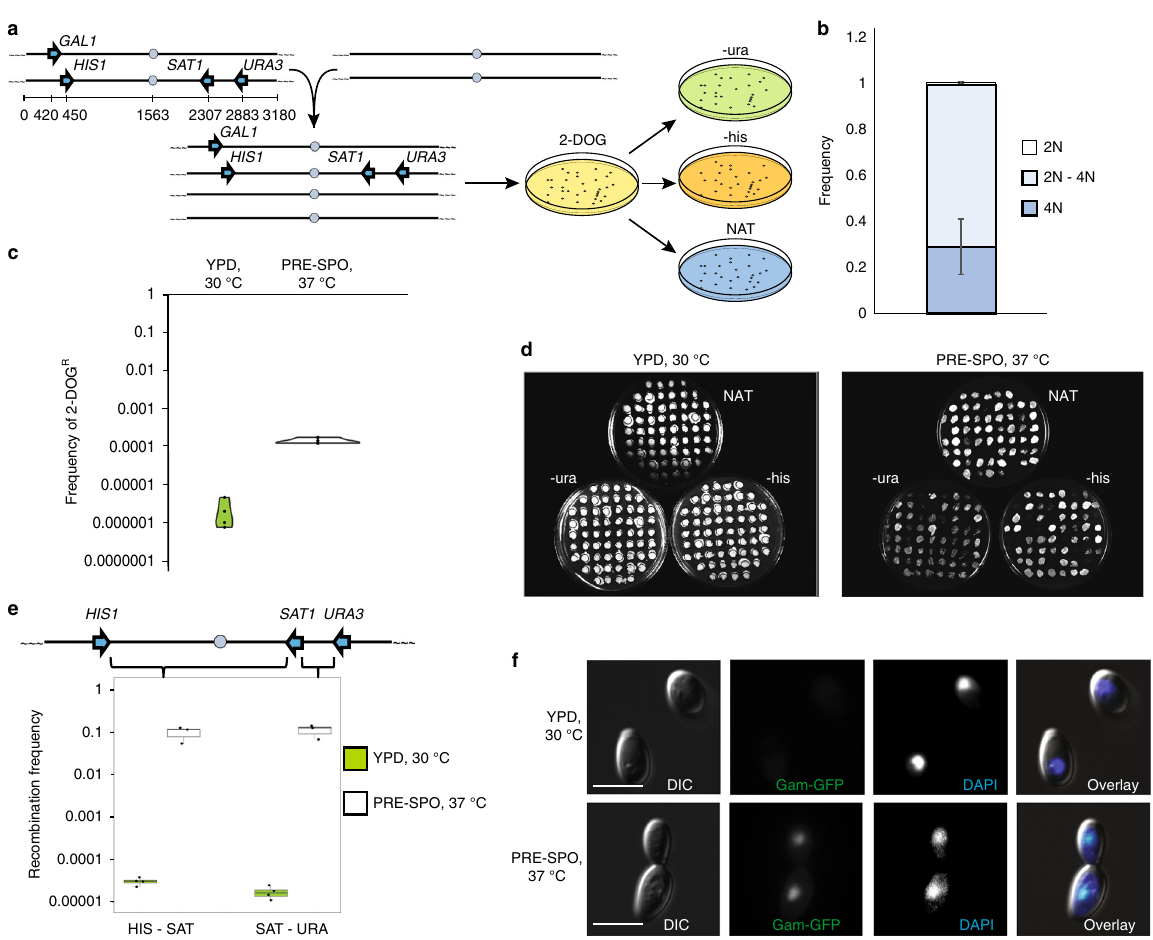
Fig. 1 High rates of inter-homolog recombination during concerted chromosome loss (CCL). a Schematic showing the construction and screening of a genetically marked tetraploid strain for monitoring chromosome loss and recombination. b Frequency of different ploidy states in 2-DOG R ( gal1 − ) progeny derived from tetraploid cells by CCL. Error bars signify standard deviation. n = 3 biologically independent experiments. c Frequency of 2-DOG R colonies following growth of the genetically marked tetraploid strain on solid agar under standard conditions (green; YPD, 30 °C) or under conditions that promote CCL (white; PRE-SPO medium, 37 °C) for 7 days. n = 4 biologically independent experiments. d Example images of selection plates indicating growth of progeny on selective media for different markers. e Recombination frequencies in HIS1-SAT1 and SAT1-URA3 intervals following growth on standard medium (green) or CCL-inducing medium (white) for 7 days. SAT1 encodes resistance to nourseothricin (NAT R ). Boxplots are presented as the 75th to 25th percentile with the thick line denoting the median. Whiskers indicate the largest and smallest values within 1.5 × of the interquartile range. f C. albicans tetraploid cells expressing the Gam-GFP construct following 24 h growth on PRE-SPO or YPD medium (CCL-inducing or standard growth conditions, respectively). Scale bar, 5 μ m. Error bars indicate